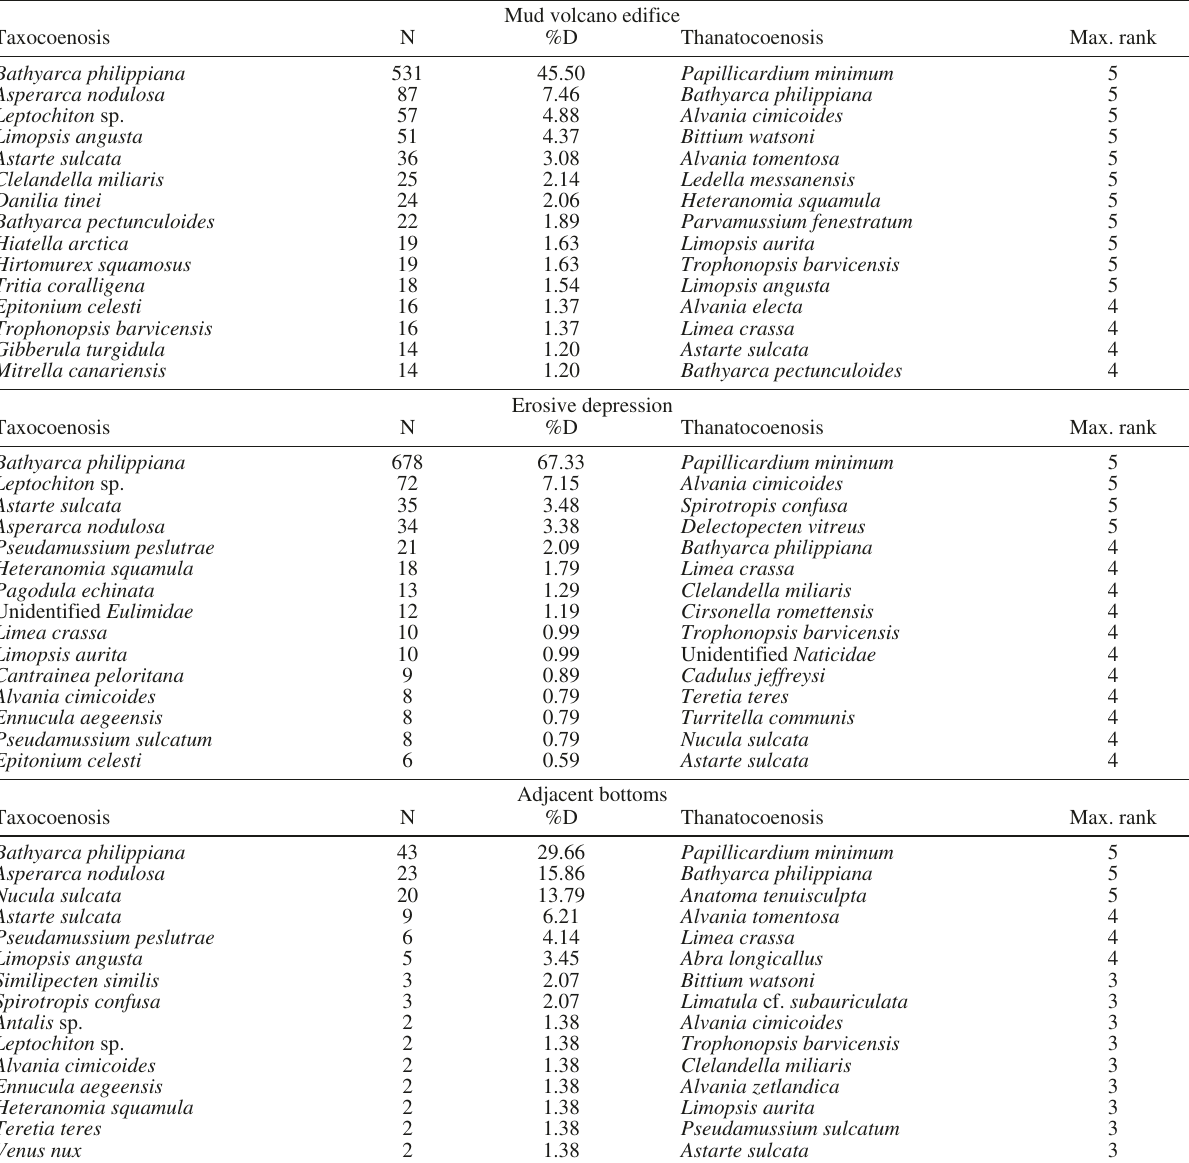
Table 5. – Number of individuals collected alive (N) of the top-dominant species found in the areas of the Gazul mud volcano (mud volcano edifice, erosive depression and adjacent bottoms) with their dominance index (%D) and the maximum observed rank (3, 6-30; 4, 31-100; 5, >100 shells) of the most representative species of the thanatocoenosis, all samples.